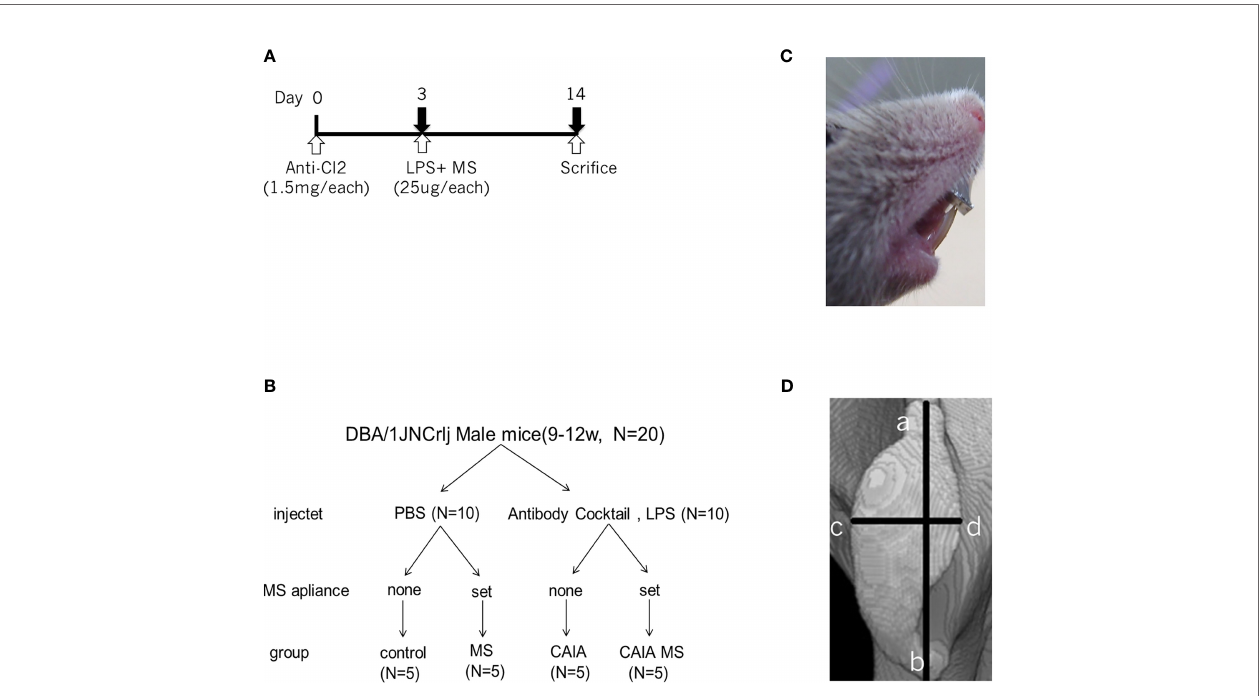
FIGURE 1 | Experimental method. (A) Experimental time schedule. (B) Details of the treatments among the groups. (C) Mechanical stress application to the mandibular condyle. (D) Linear measurement diagram of the mandibular condyle. The major length (a, b) and width (c, d) of the mandibular condyle: a is the anterior point, b the rearmost point, and c and d are the innermost and outermost points,